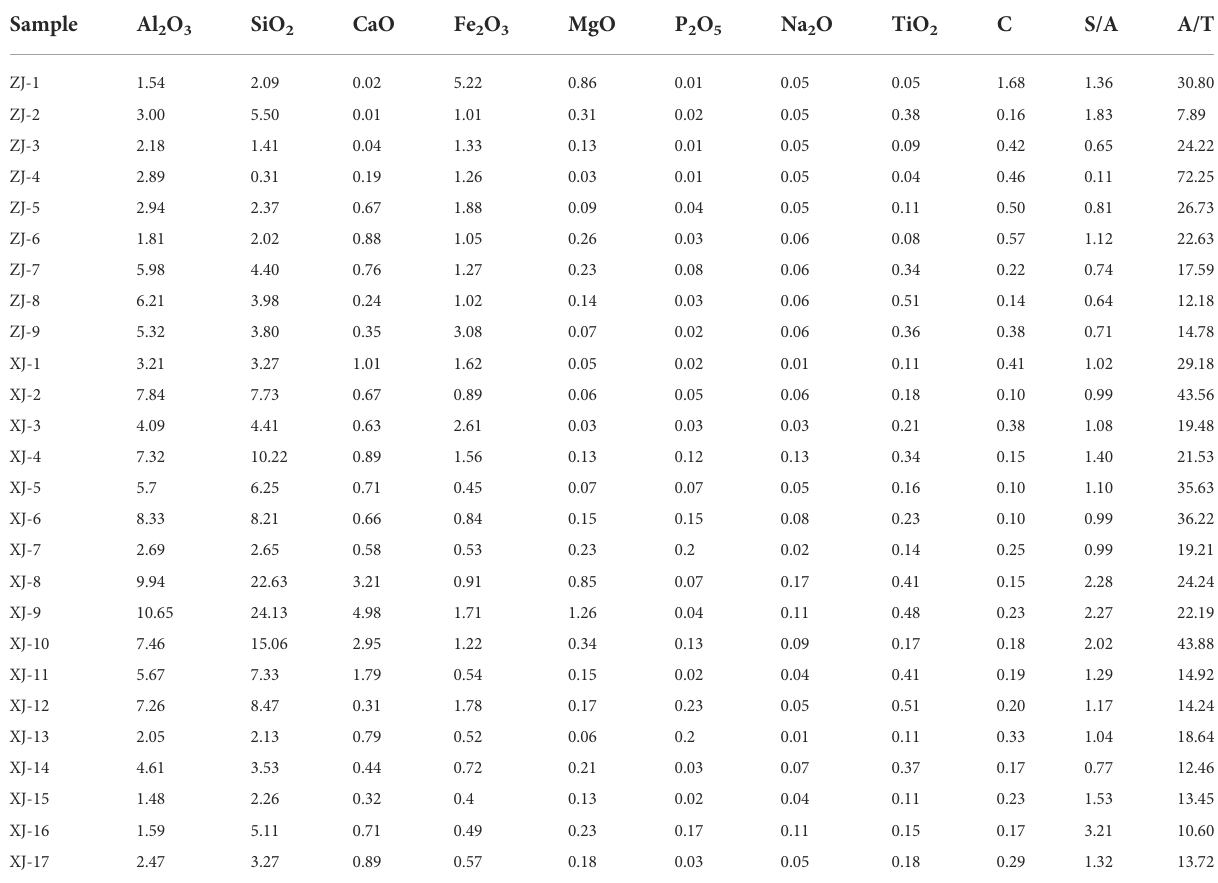
TABLE 1 Ash composition ratio of